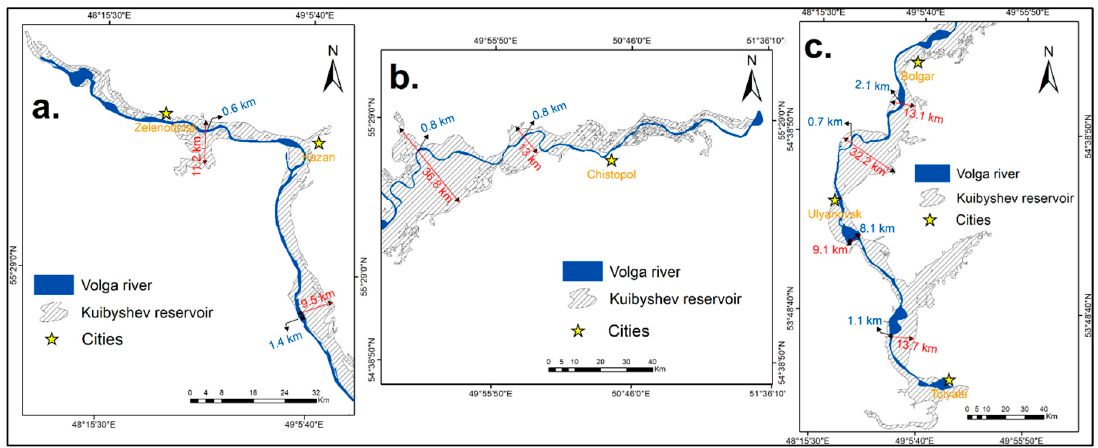
Figure 5. Results of the coastal dynamics analysis for: ( a ) Sector 1; ( b ) Sector 2; ( c ) Sector 3.